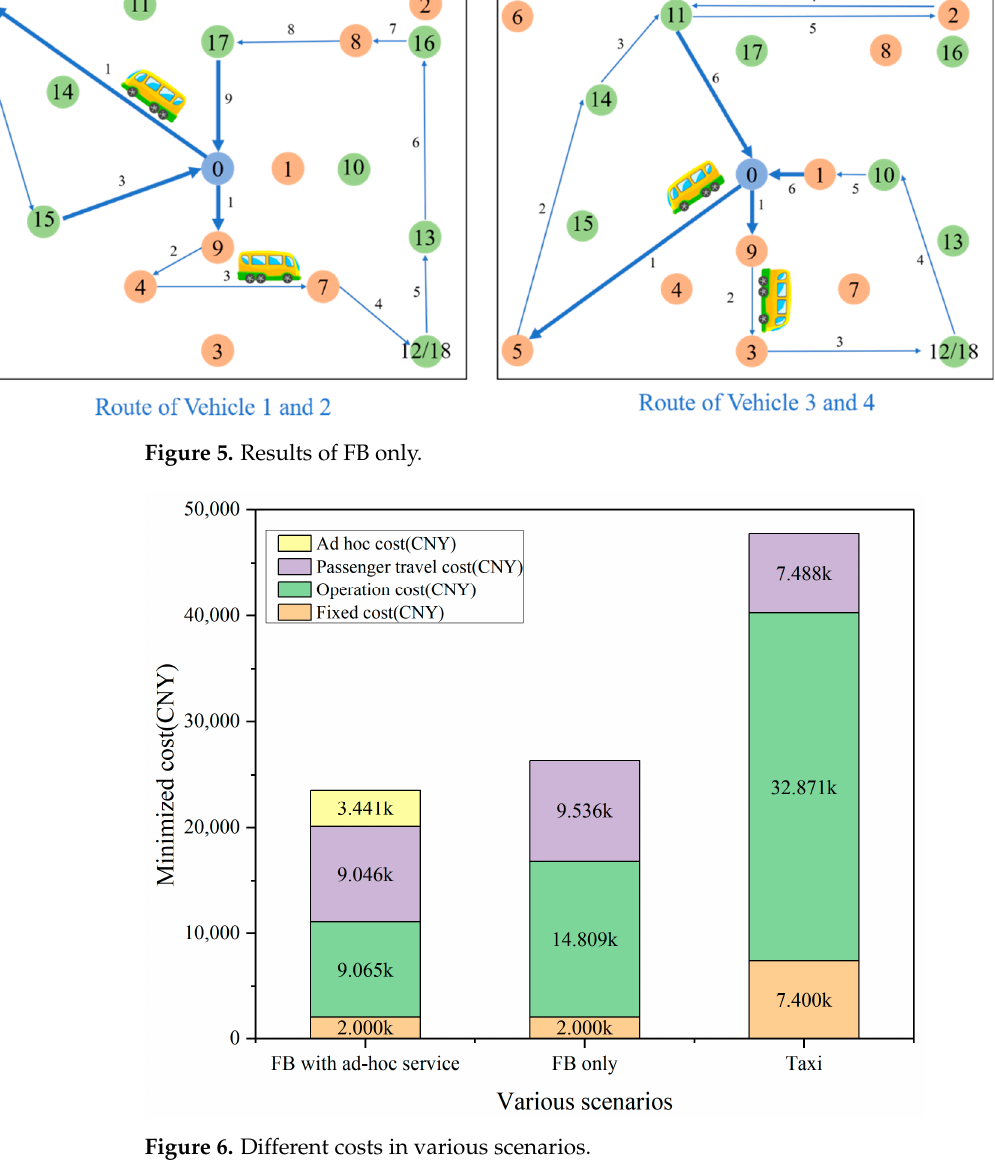
Figure 6. Different costs in various scenarios.